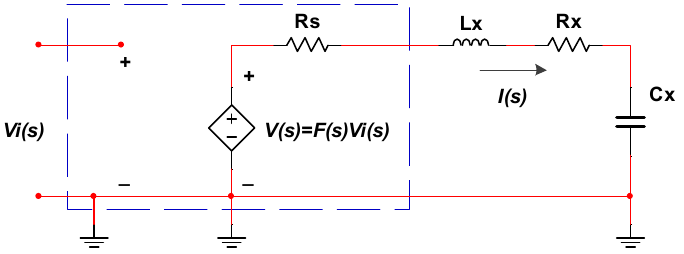
Figure 9. Frequency domain model of the circuit with piezoelectric stack actuators.